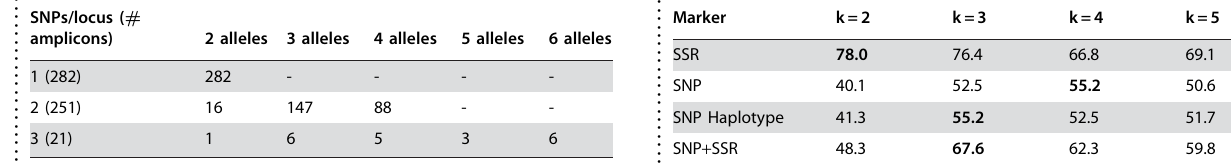
SNPs/locus ( # amplicons)